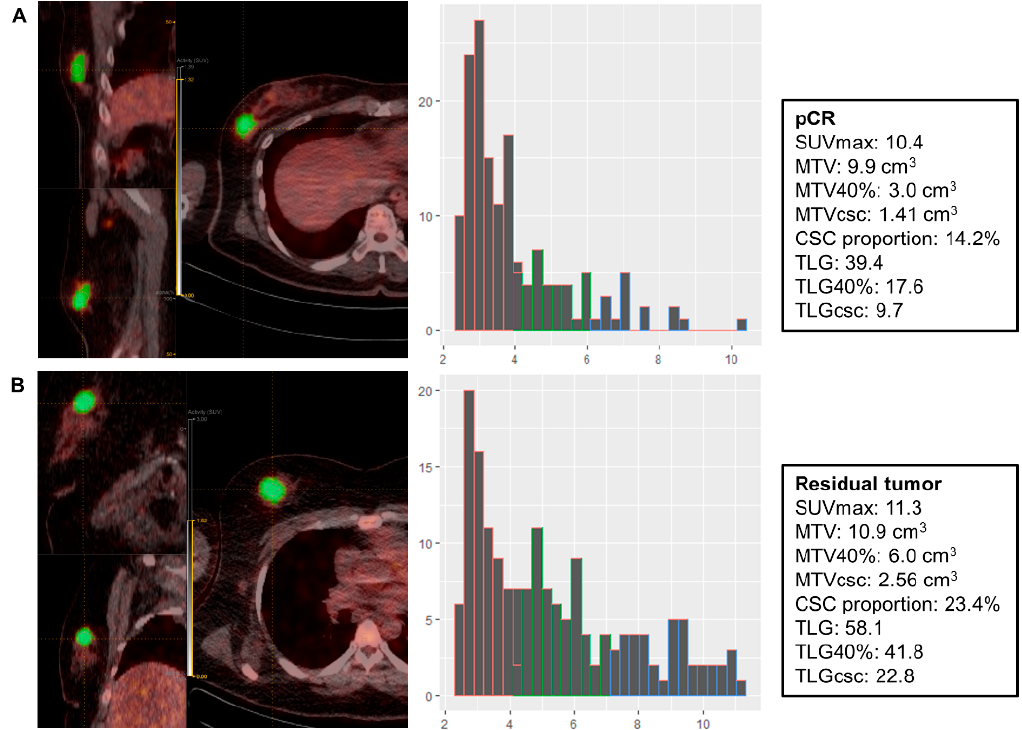
Figure 2. Representative cases of a patient with pCR and a patient with the residual tumor. ( A ) A patient with the triple negative subtype (cT2N1) achieved pCR after receiving AC + T #8. ( B ) A